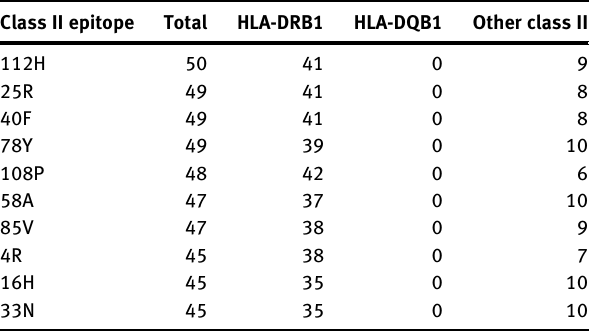
Table  : Most shared epitope list by class II alleles. Class II